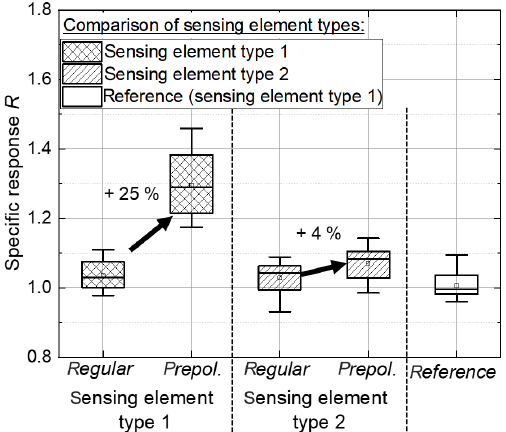
Figure 6. Specific response of type 1 and 2 sensors operated by both regular and prepolarization strategy. The values of R are scaled to the mean specific response of the reference sensors. The experiment was carried out at the Daimler OM646 test bench.